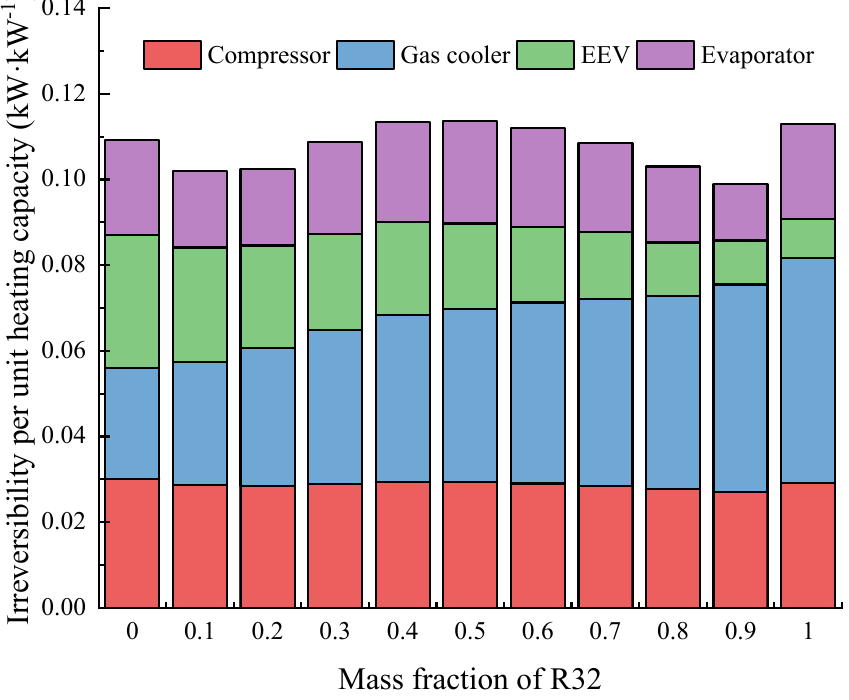
Figure 6. The irreversibility per unit heating capacity across the R32 mass fraction range.